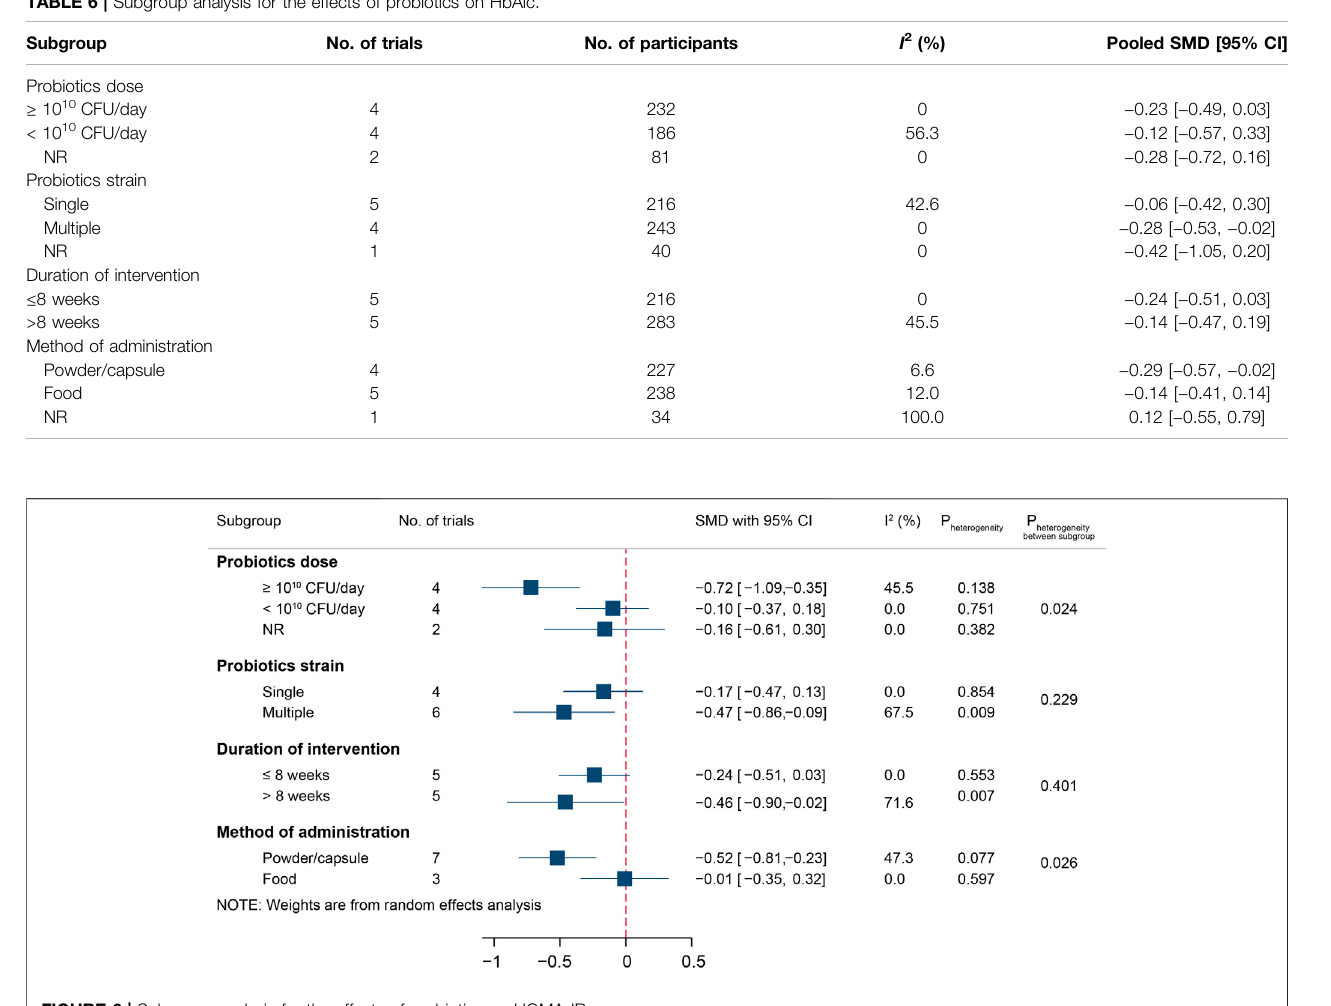
FIGURE 6 | Subgroup analysis for the effects of probiotics on